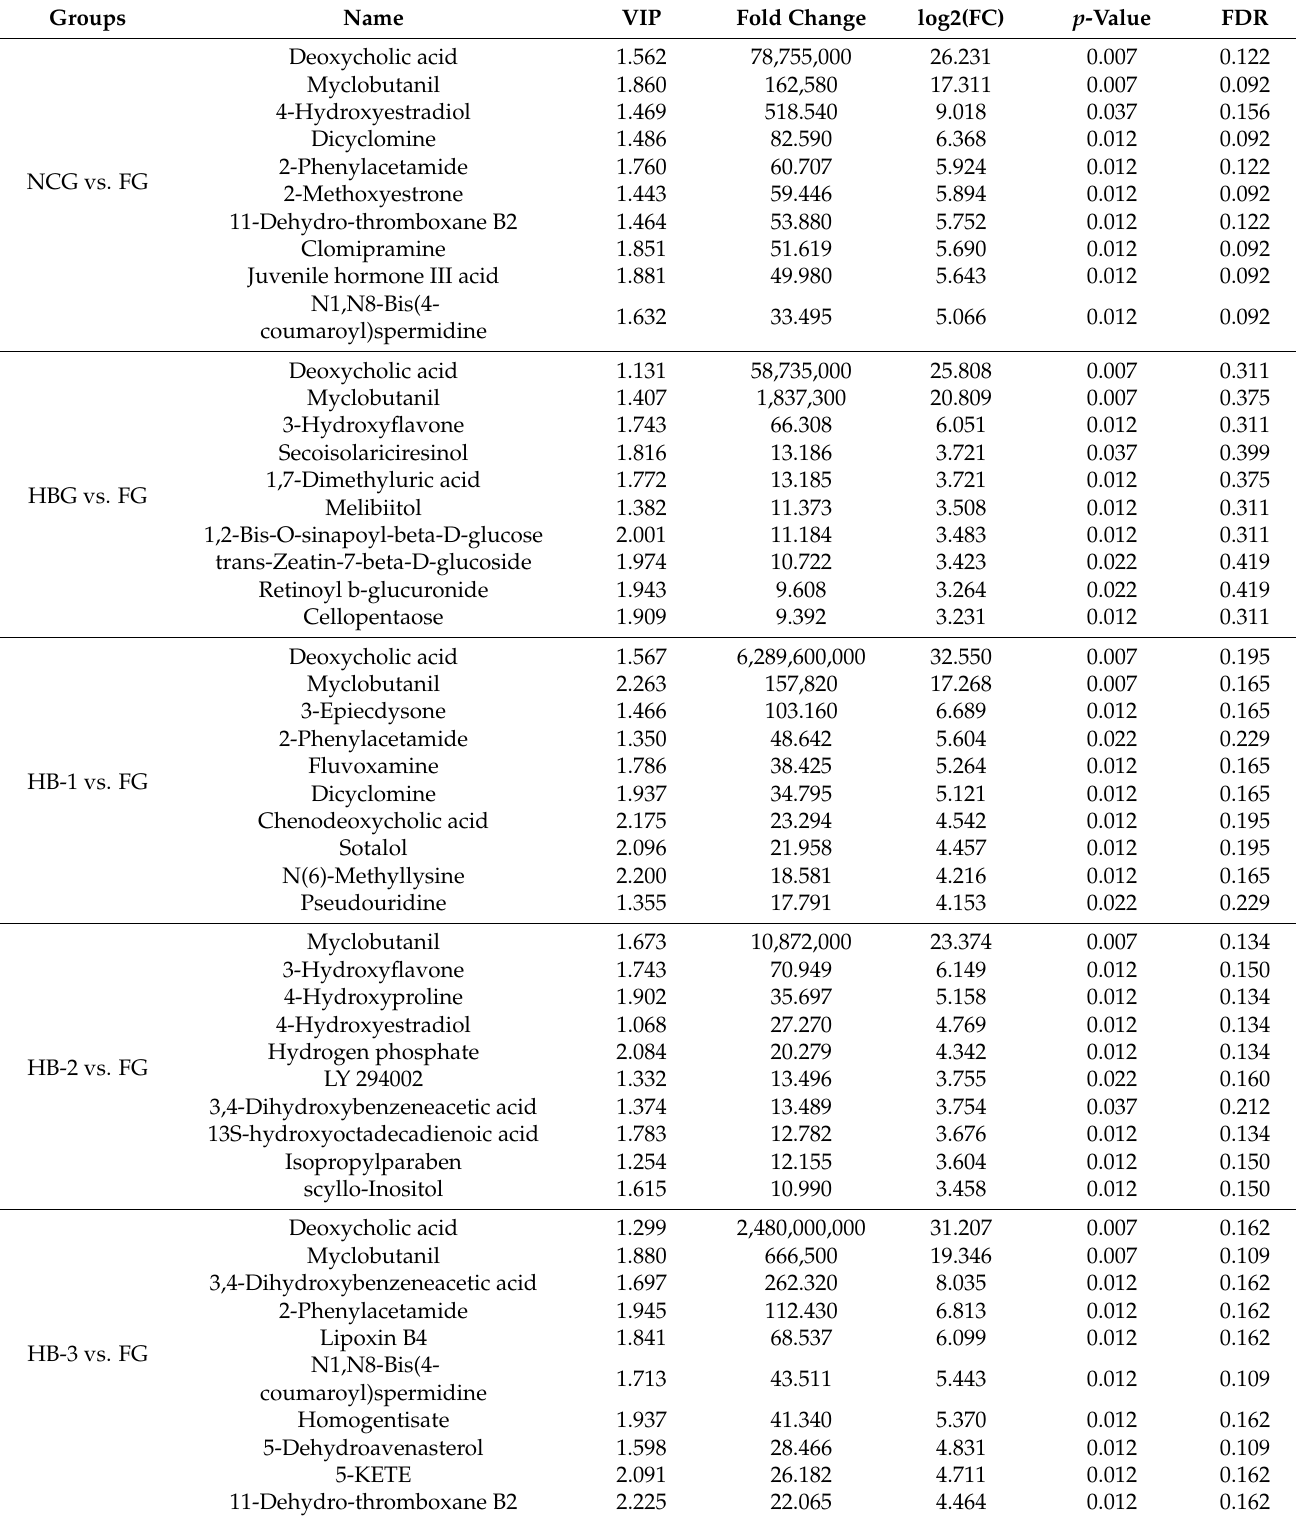
Table 5. Statistical data of important differential metabolites in